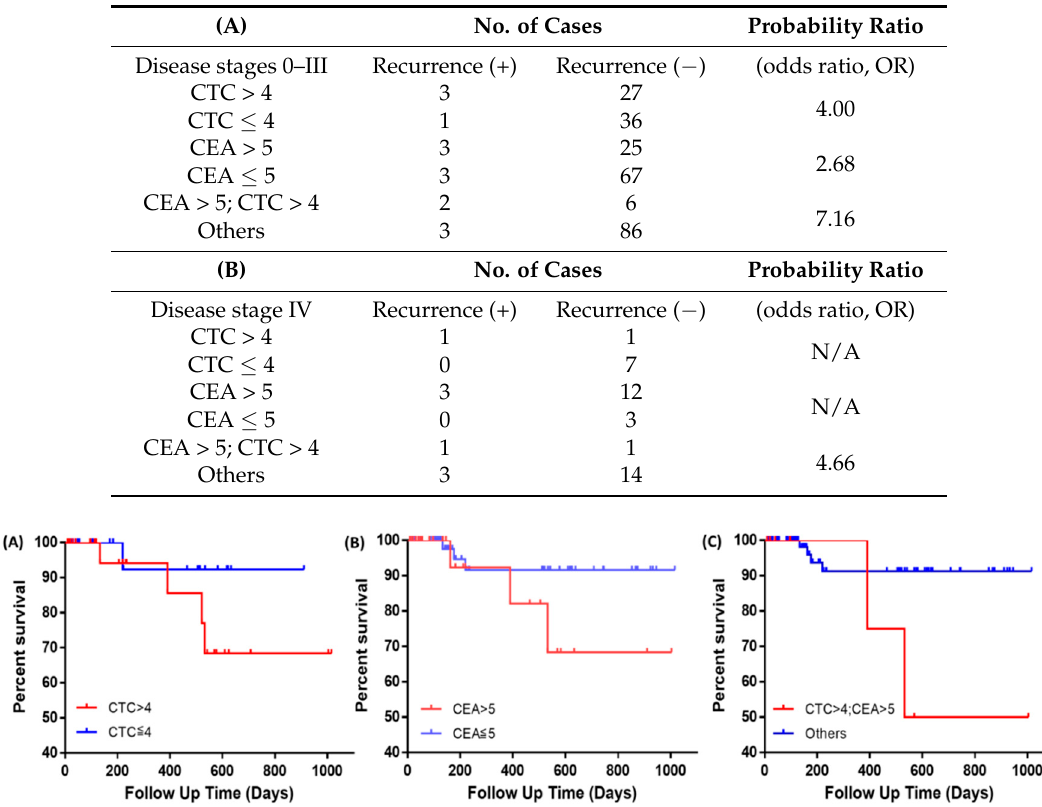
Table 3. Odds ratios (ORs) of CTC, CEA, and their combination to predict recurrent events. Data from patients with non-metastatic CRC are listed in (A), and data from patients with metastatic CRC are listed in (B). N/A: not analyzable due to absence of recurrent event.